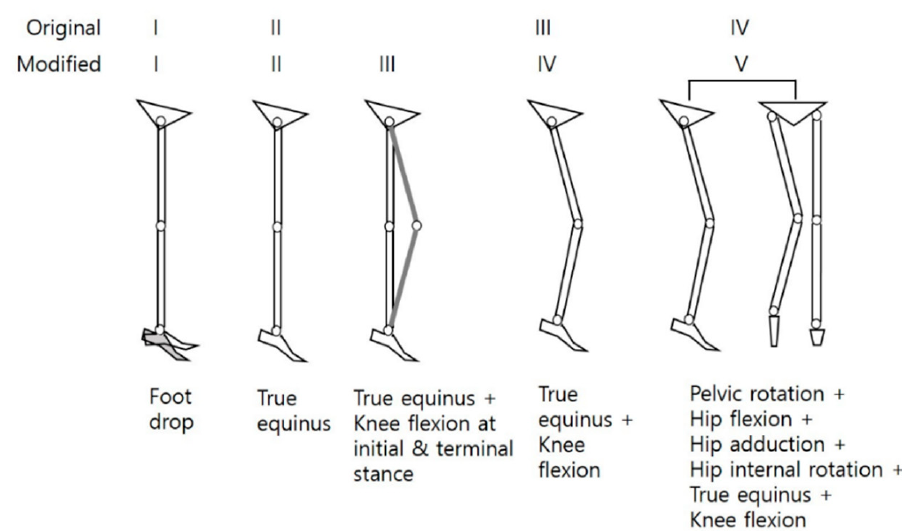
Figure 3. The Winters classification (modified and reproduced) [23,31].